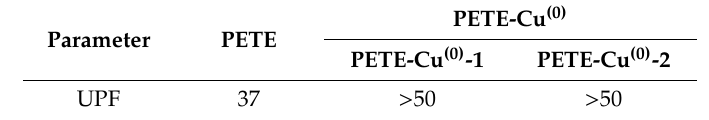
Table 3. Ultraviolet Protection Factor (UPF) values of PETE knitted textile and PETE-Cu (0) composites. Parameter